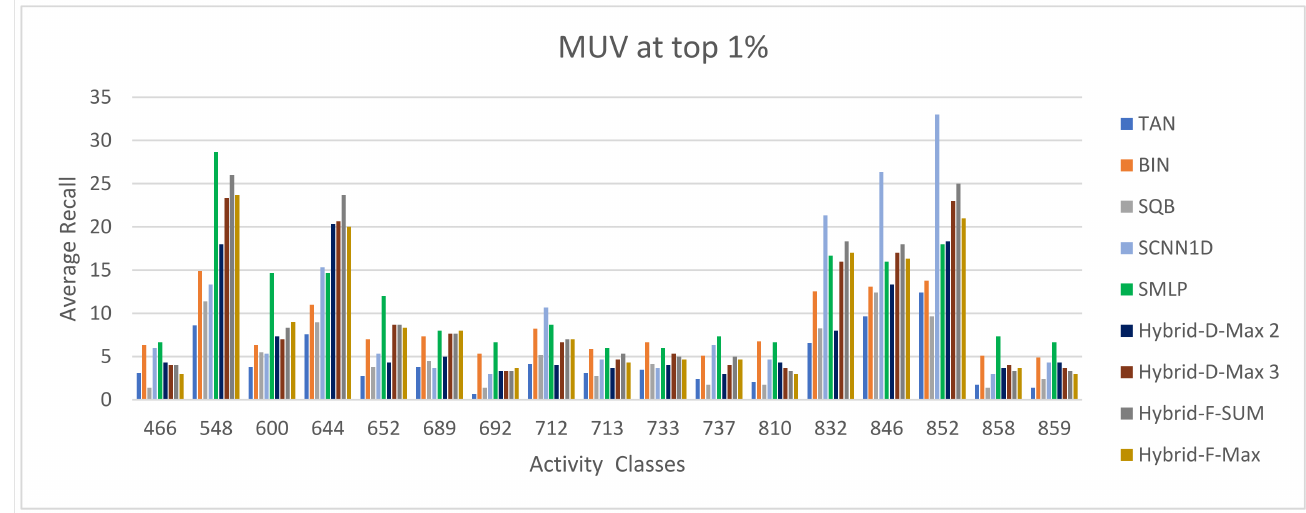
Figure 14. The comparison among methods for the average recall percentage at the top 1% in MUV. Table 12. Top 5% retrieval recall for MUV dataset for descriptor